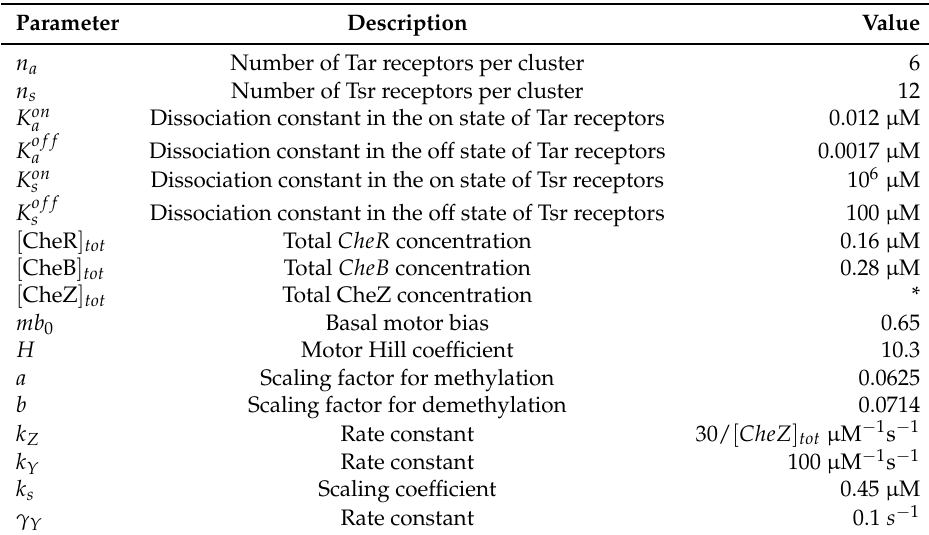
Table A2. Descriptions and values of predetermined parameters in RapidCell model